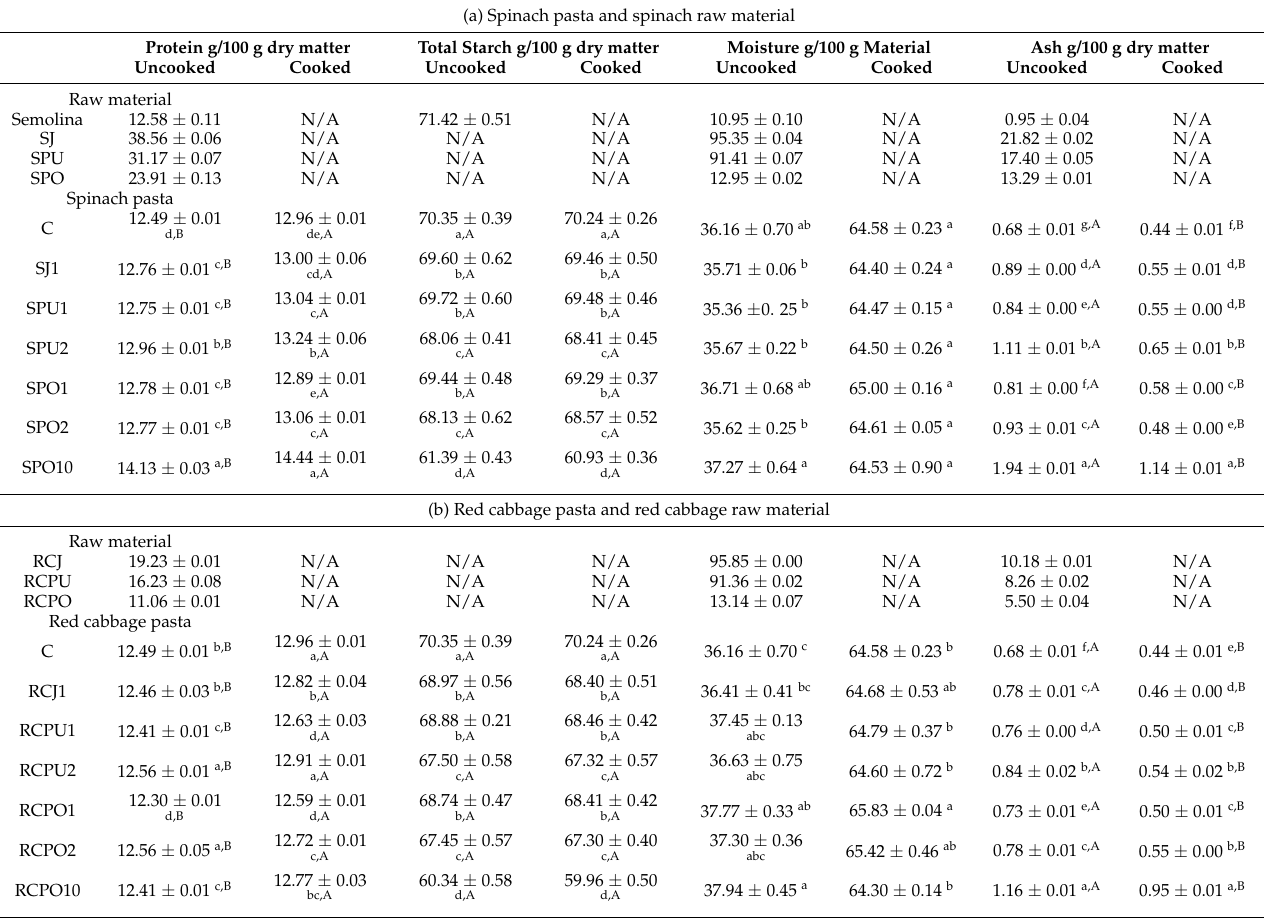
Table 2. Proximate chemical analysis of vegetable pasta. (a) Spinach pasta and spinach raw material